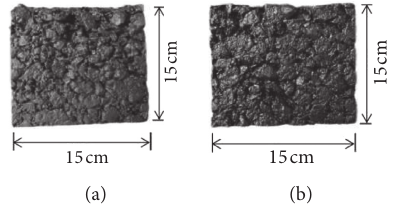
X NO x detector.